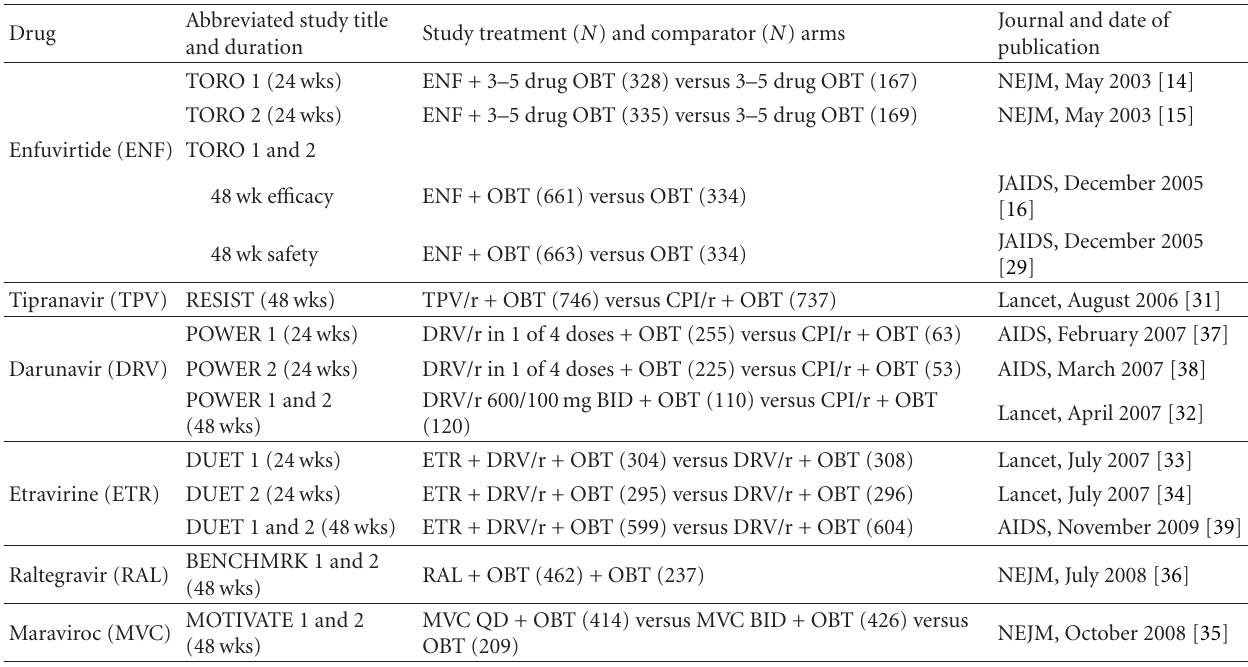
Table 1: Publications of pivotal studies of drugs for multidrug-resistant HIV.